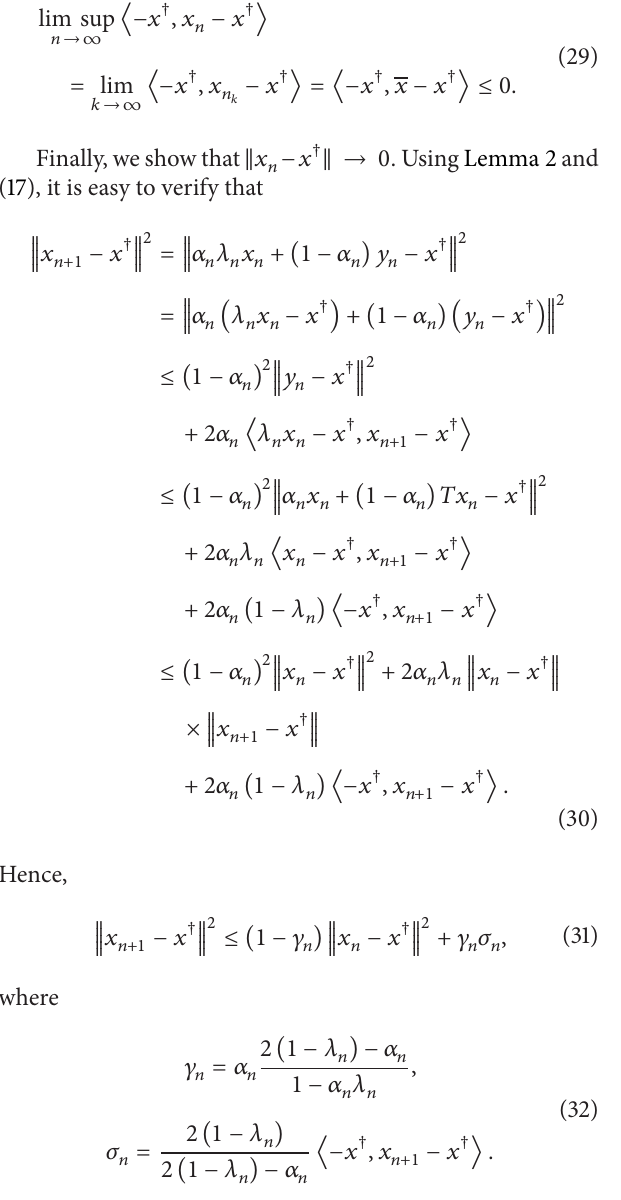
Algorithm 11. Define {𝑥 𝑛 } in the following